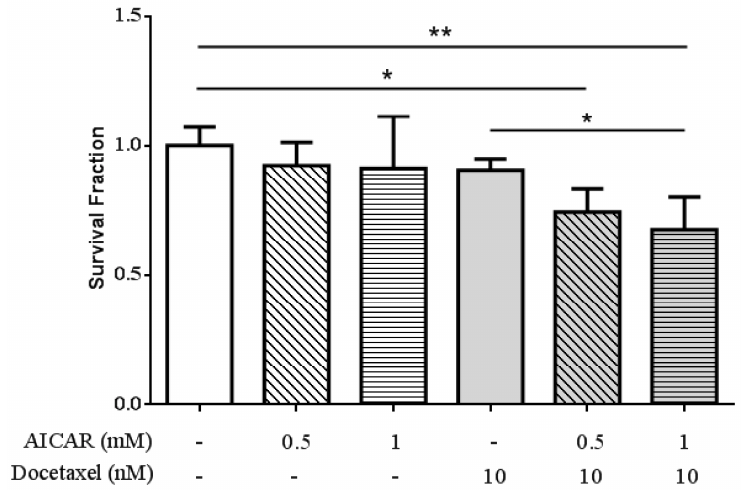
Figure 5. Effect of AICAR on the sensitivity of 22Rv1 prostate cancer cells to docetaxel treatment. Cells were treated with different concentrations of AICAR in the presence or absence of docetaxel for 24 h. The cell viability was measured by the MTT assay. Data are represented as means ± SD of triplicate values and statistical significance was determined using the Student’s t -test (* p < 0.05; ** p < 0.01).